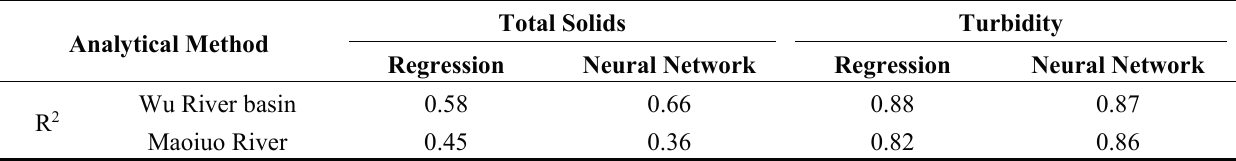
Table 4. Comparison between the results of regression and neural